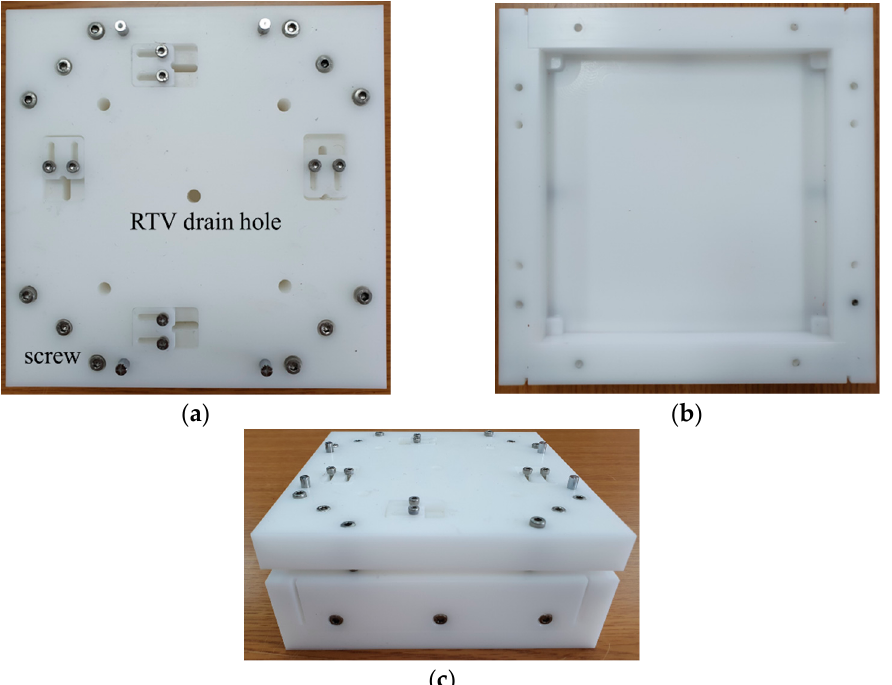
Figure 9. Photograph of the potting mold: ( a ) top plate; ( b ) bottom plate; ( c ) top and bottom plates assembled.